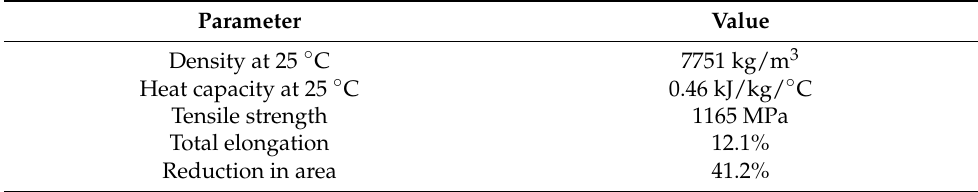
Table 2. Physical and mechanical properties of SWRS82B steel.